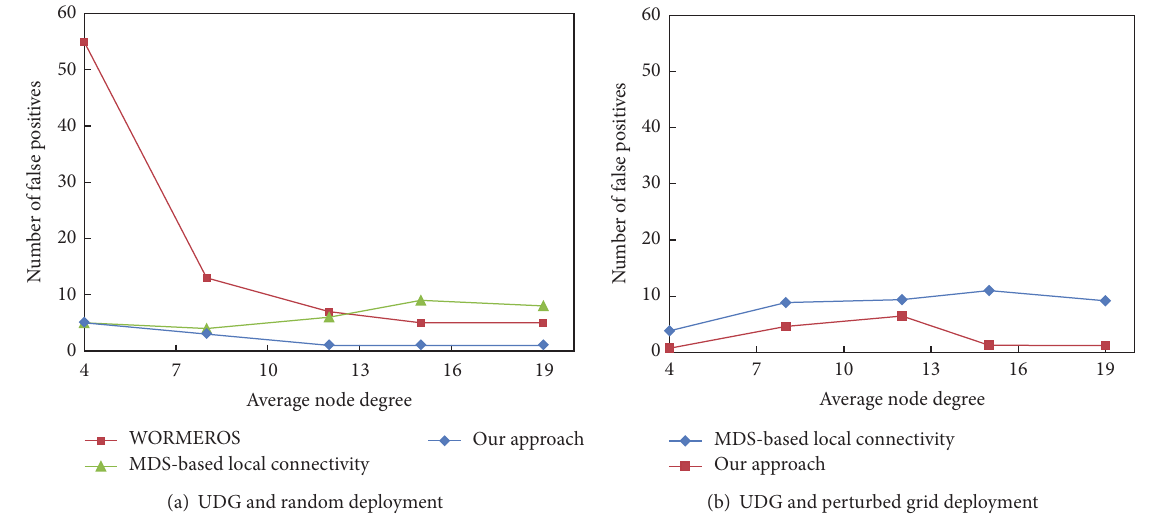
Figure 4: False positive rate with average node degree in (a) and (b).